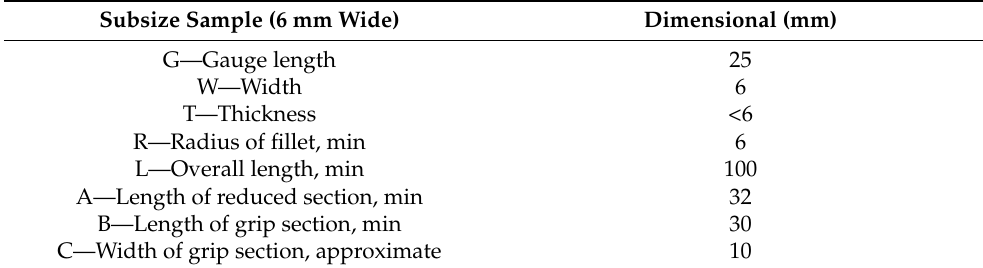
Table 3. The standard size specifications for dog-bone recycled specimens.